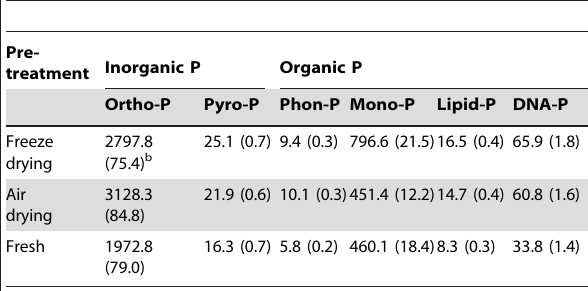
Table 3. Influence of pre-treatment on the concentrations a (mg kg 2 1 ) of individual P components, analyzed by 31